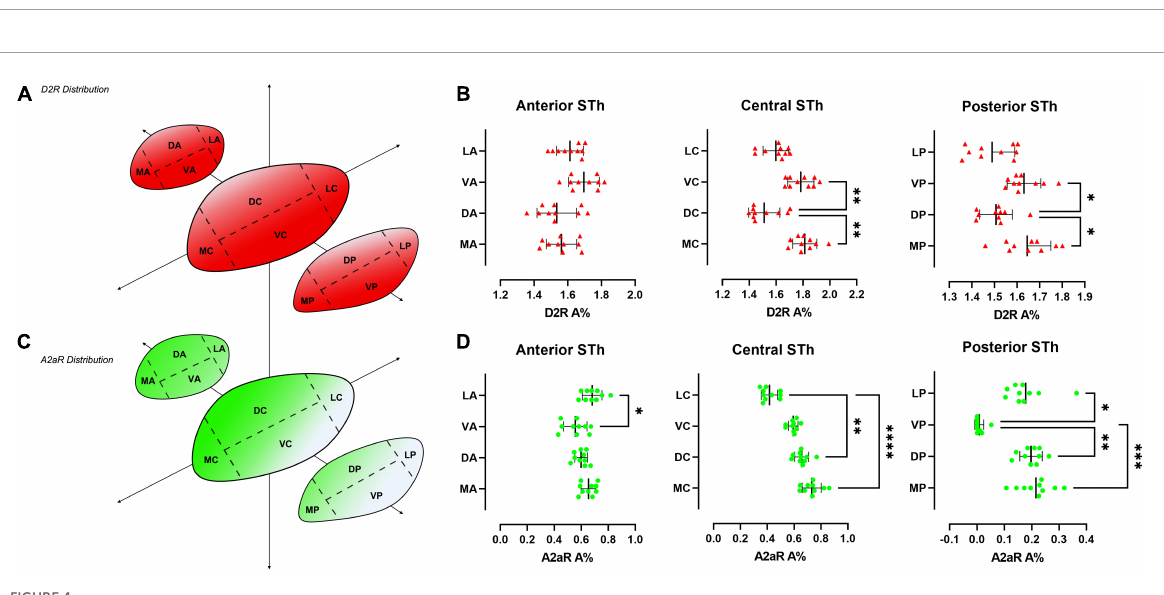
FIGURE4 Heatmap of the distribution of D 2 R (A) and A 2 A R (C) throughout the rostro-caudal extent of the STh, indicating a decreasing ventral-to-dorsal gradient for D 2 R, and an opposite decreasing dorsomedial-to-ventral gradient for A 2 A R. (B,D) Non-parametric ANOVA (Friedman’s test) of the different levels of sectioning throughout the STh reveals topographical differences within specific STh